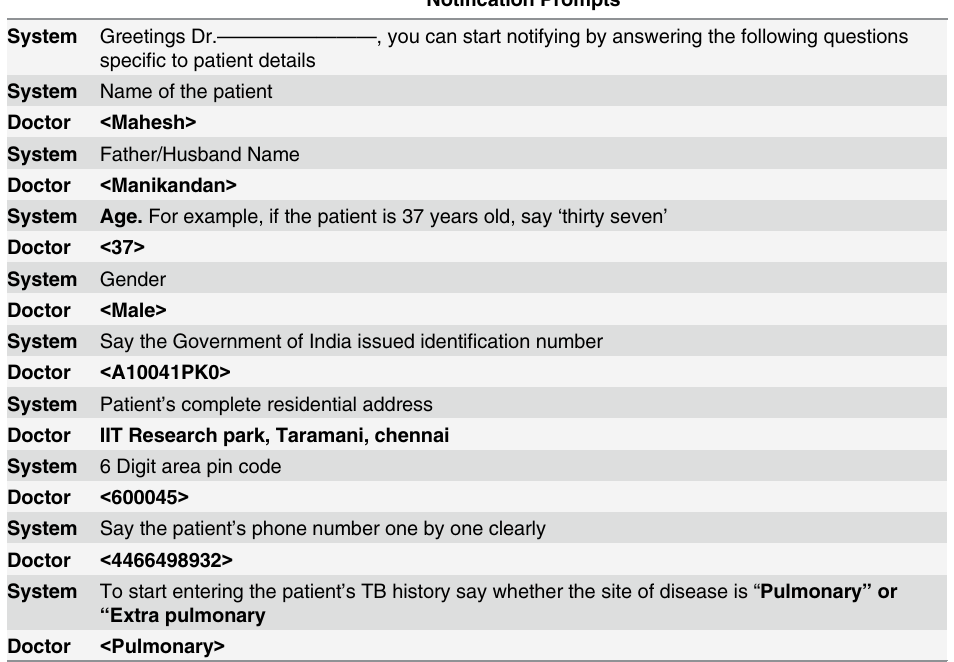
Table 1. Sample Interactive Voice Response System (IVRS) call for TB notification. Noti fi cation